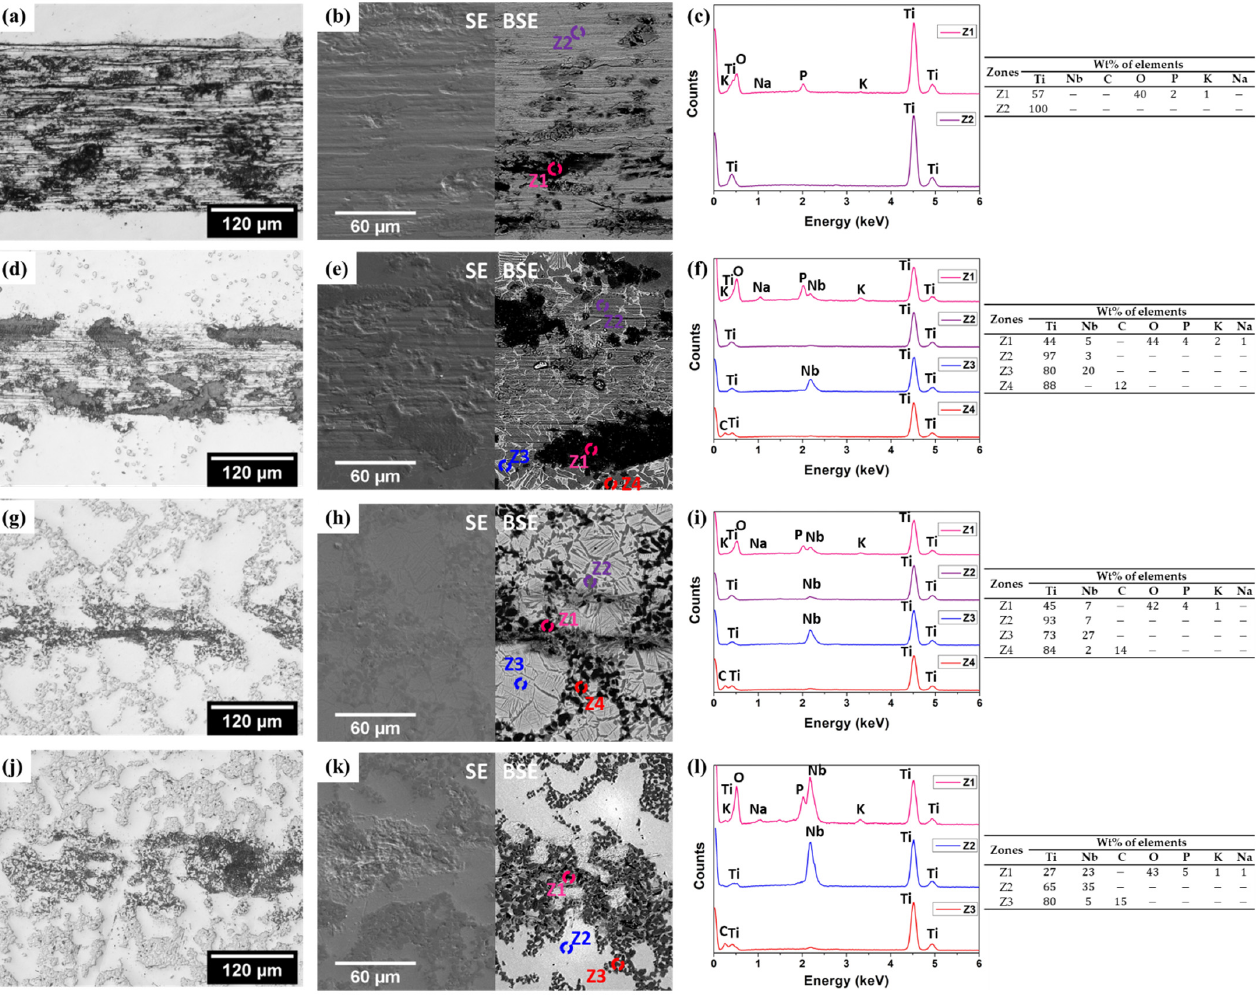
Figure 8. OM and SEM images together with EDS spectra of worn surfaces after tribocorrosion performed under OCP for: unreinforced Ti ( a – c ), Ti+5NbC ( d – f ), Ti+12.5NbC ( g – i ), and Ti+20NbC sion performed under OCP for: unreinforced Ti ( a – c ), Ti + 5NbC ( d – f ), Ti + 12.5NbC ( g – i ), and ( j – l ). Ti + 20NbC ( j – l